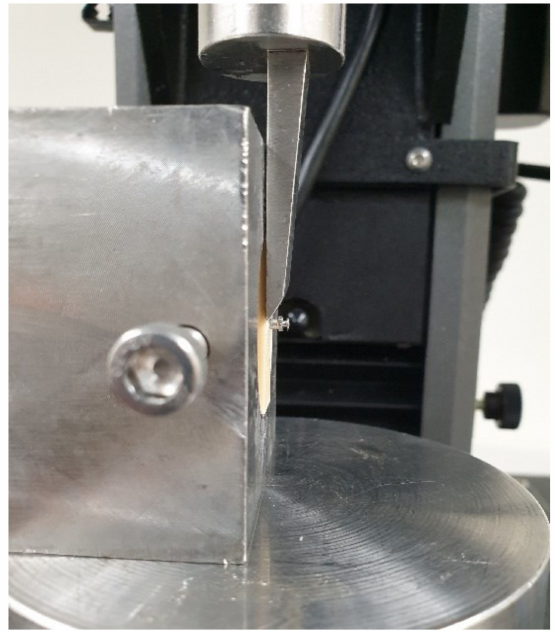
Figure 3. Digital photograph of the horizontal resistance test